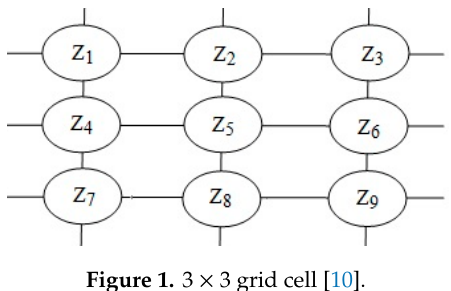
Figure 1. 3 × 3 grid cell [10].